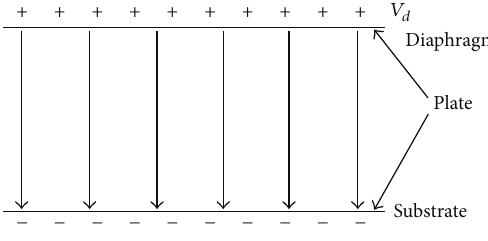
Figure 4: The electric field in MEMS pressure